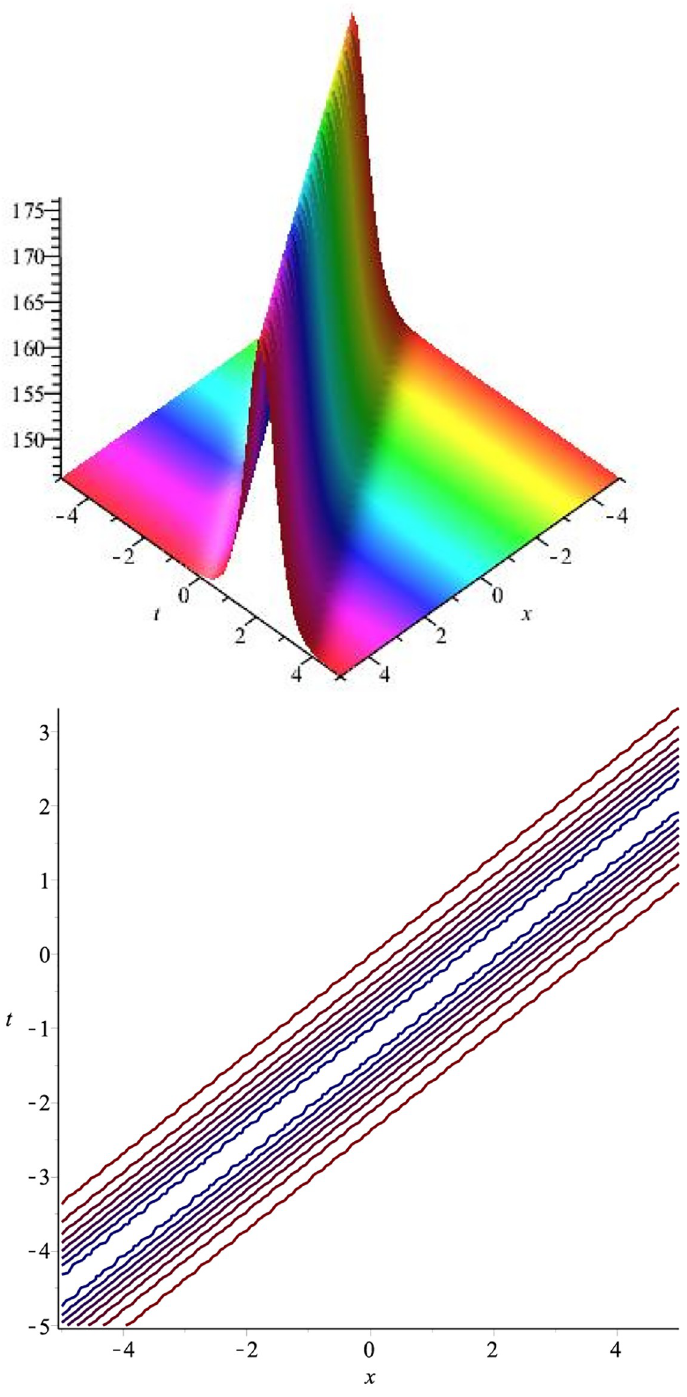
Fig 1. Bright soliton: j v 1 ( x , t ) j for l = 1.9, m = 1.5, λ = 3.7, c = − 2.4, v = 1.5, β = 1, μ = 2.4.